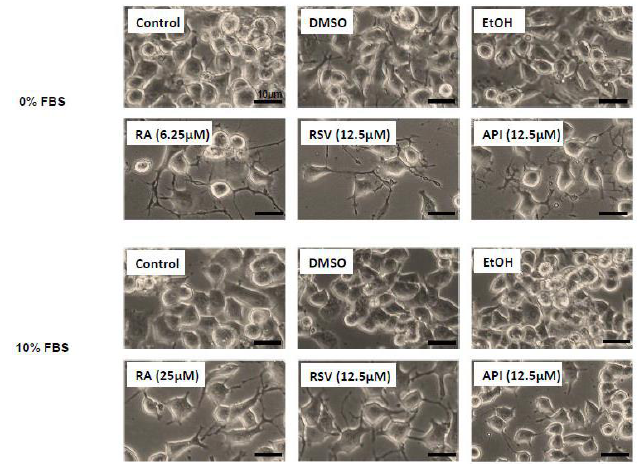
Figure 1. Morphological evaluation of neuronal differentiation of neuro-2a (N2a) cells treated with resveratrol, apigenin, and retinoic acid used as positive control. Murine neuronal N2a cells previously cultured for 24 h in conventional cultured medium were further cultured for 48 h in medium without or with 10% fetal bovine serum (FBS) in the absence or in the presence of retinoic acid (RA: 6.25 and 25 µM) respectively, used as positive control for the induction of neuronal differentiation, or with polyphenols: resveratrol (RSV 12.5 µM) and apigenin (API 12.5 µM). Control cells were cultured in medium without or with 10% FBS. Two vehicle controls were realized: ethanol (EtOH) used with RSV, and dimethyl sulfoxide (DMSO) used with RA and API. Observations were realized by phase contrast microscopy. Differentiated cells, characterized by neurite outgrowth (dendrites and/or axons), are observed in the presence of RSV, API, and RA. Diseases 2018 , 6 , x FOR PEER REVIEW